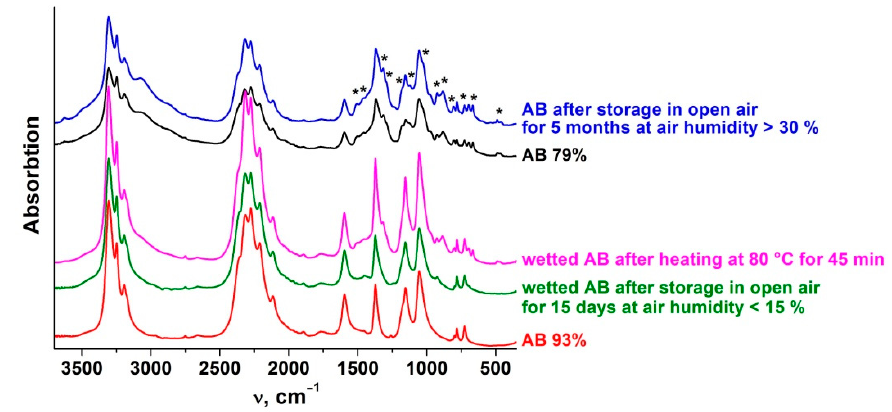
Figure 3. ATR FTIR spectra of samples of NH 3 BH 3 interacting with water under different conditions, and of the samples of NH 3 BH 3 of different purity. The absorption bands not belonging to NH 3 BH 3 are marked by *.